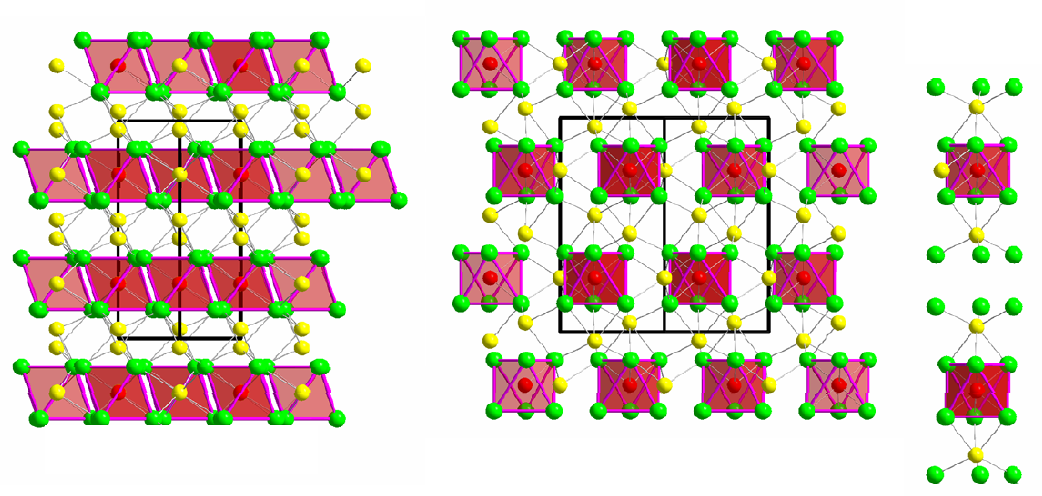
Figure 2. Views of the crystal structure of Na the hexagonal closest packing of chloride ions (green) and the occupation of octahedral voids by sodium (yellow) and molybdenum (red) ions. Middle: A [110] projection. Right: A sequence of triple octahedra {Cl [001] direction.